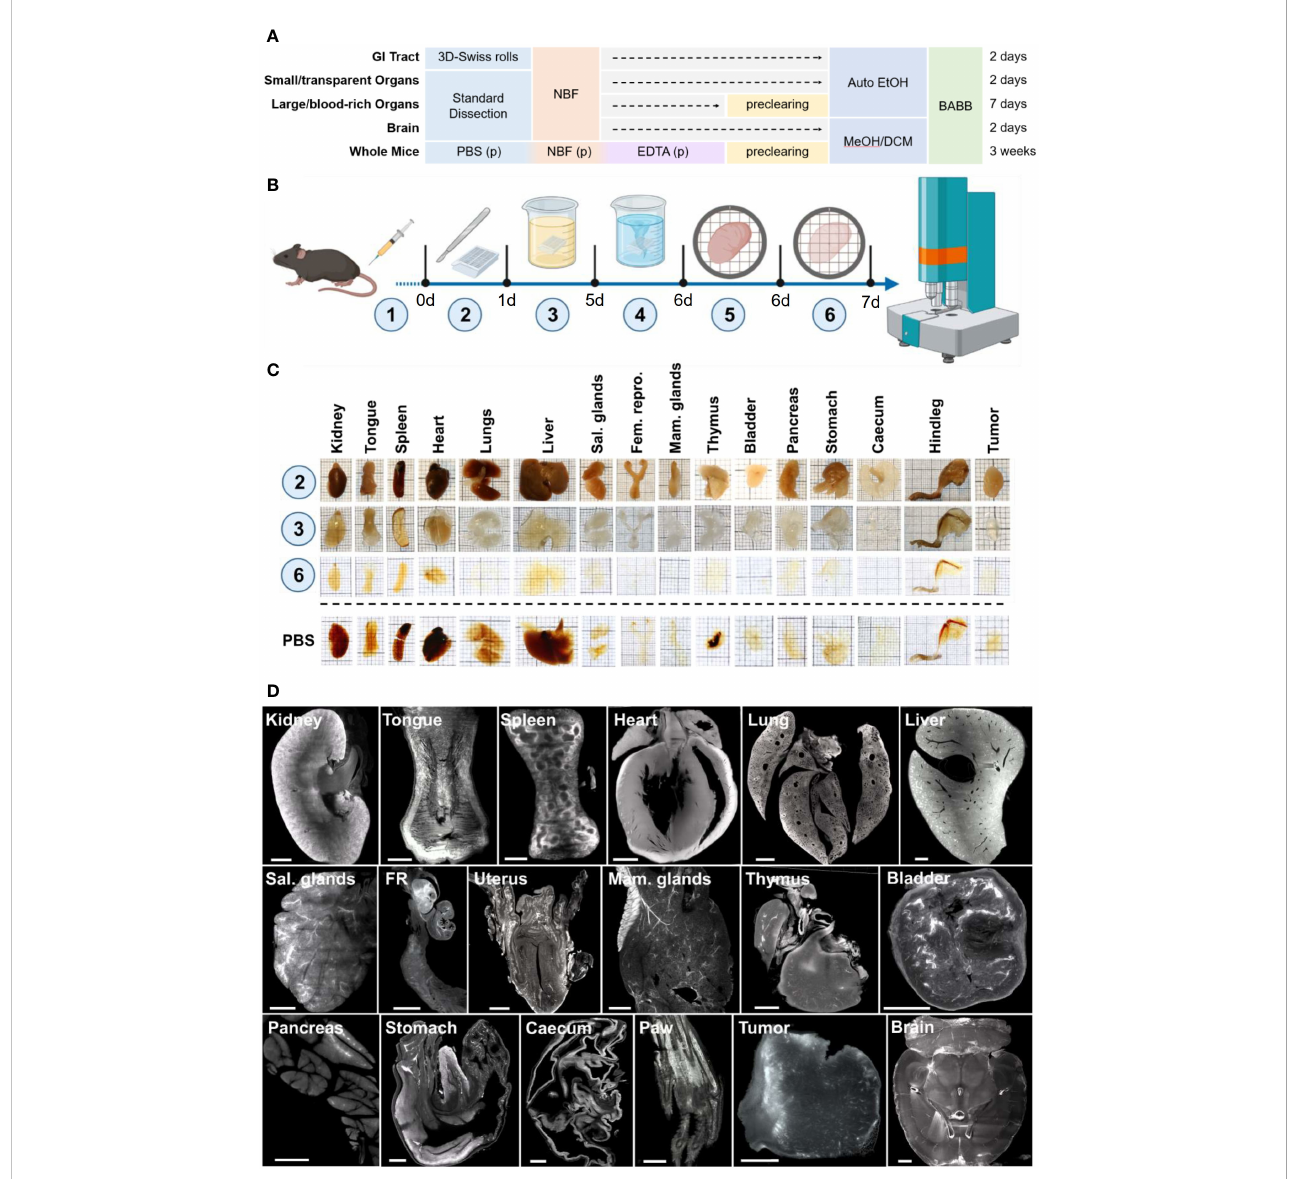
FIGURE 1 Modular clearing approach of the ROCKETS processing toolbox allows for simpli fi ed sample preparation for LSFM imaging. (A) Overview of presented procedures for processing and simpli fi ed clearing of mouse tissues or whole mouse bodies. GITs are processed using the 3D-Swiss Rolls procedure prior to fi xation to enable holistic imaging. Other internal organs and tissues can be processed according to size and blood content. Non-perfused large and blood-rich tissues are precleared using the developed preclearing reagent before dehydration. Smaller tissues with less blood content do not require preclearing. All tissues except for the brain and whole mice are dehydrated with ethanol using an automated vacuum tissue processor. Due to its high lipid content, the brain is dehydrated in methanol and additionally delipidated using dichloromethane (MeOH/DCM). Only whole mice require perfusion to ensure timely fi xation and decalci fi cation of bones before the preclearing step. All specimens are cleared (RI matching) and imaged in BABB. Indicated times are total processing times from the day of dissection to cleared specimens. (p) = perfusion. (B) Work fl ow of passive preclearing of non-perfused murine tissues. Fluorescence-labeled molecules are applied in vivo (1) prior to euthanasia, tissue dissection and fi xation overnight (2). Fixed specimens are incubated in the ROCKETS preclearing reagent (3) and washed with PBS PC (4) before transfer to vacuum-enhanced dehydration (5) and RI matching with BABB (6). (C) Photographs of mouse tissues at indicated step of preclearing. Specimens are opaque and still contain blood pigments after fi xation (2). After preclearing (3) samples are fully decolorized and swollen and become completely transparent after dehydration and RI matching (6). The bottom row shows tissues after dehydration and RI matching without preclearing (immersed in PBS). Particularly blood-rich organs are insuf fi ciently cleared without perfusion or preclearing. Thick squares of the grid = 5 mm. (D) Maximum intensity projections (MIPs) of LSFM images (z = 50 µm) of the tissue ’ s auto fl uorescence (545 nm ! 595 nm) at the widest diameter of precleared tissues. FR = Female reproductive organs (oviduct and ovary), Sal. glands = Salivary glands. All tissue areas could be imaged entirely without blurring. *brain was not precleared, but dehydrated and delipidated using MeOH and DCM. Scale bars = 1